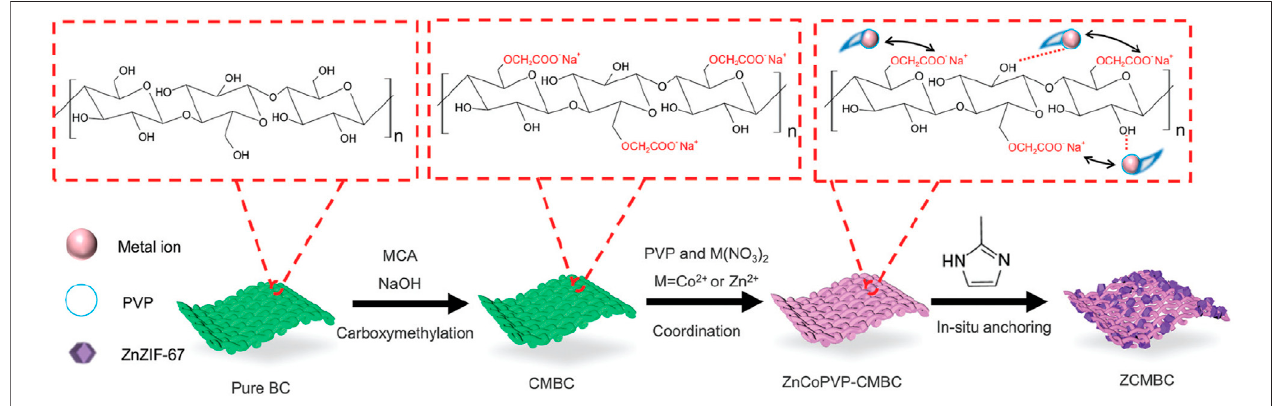
FIGURE 4 | Schematic illustration of the synthesis of ZCMBC composite fi lms (Mai et al., 2021).